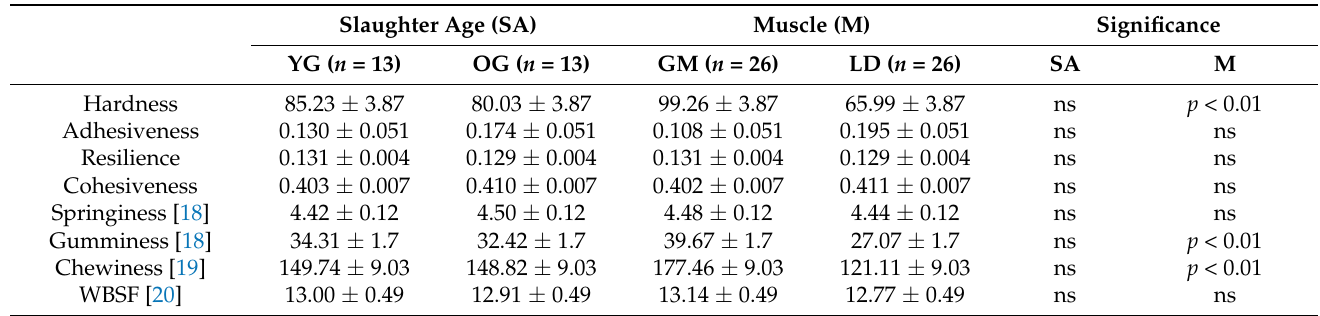
Table 3. The TPA scores and WBSF values (lb.) of the GM and LD muscles of bulls slaughtered at different ages, given as least squares means ± standard errors.